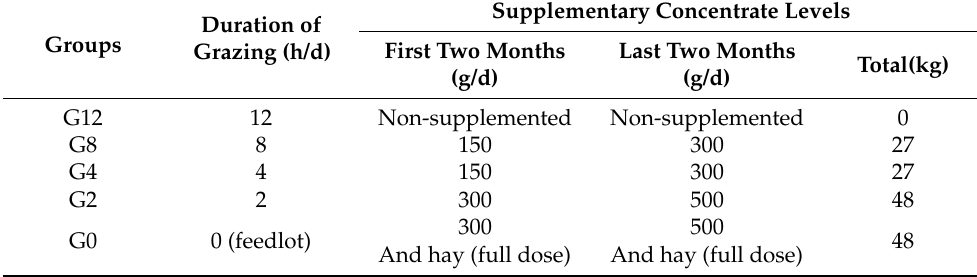
Table 1. Different feeding strategies of the five groups [19].